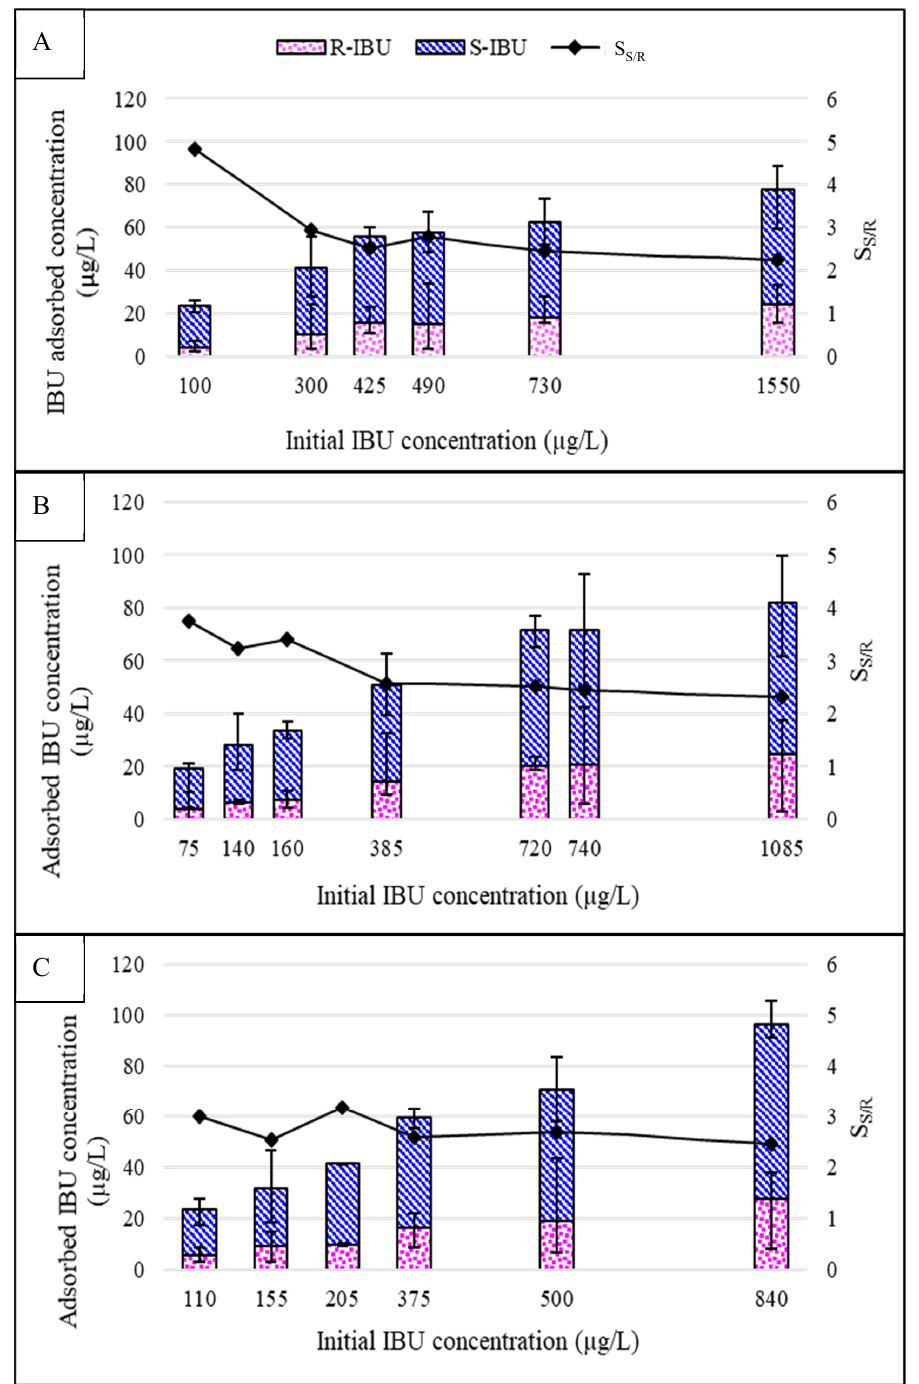
Figure 2. Adsorbed R- and S-IBU onto ( A ) Flat-sheet equipment; ( B ) Flat-sheet equipment with NF270 coupon; ( C ) Flat-sheet equipment with TS40 coupon (feed water pH of 4.0 units, temperature 20 ± 1 ◦ C). Selectivity is a ratio of adsorption of S/R IBU. Error bars represent minimum and maximum values from triplicate analysis.